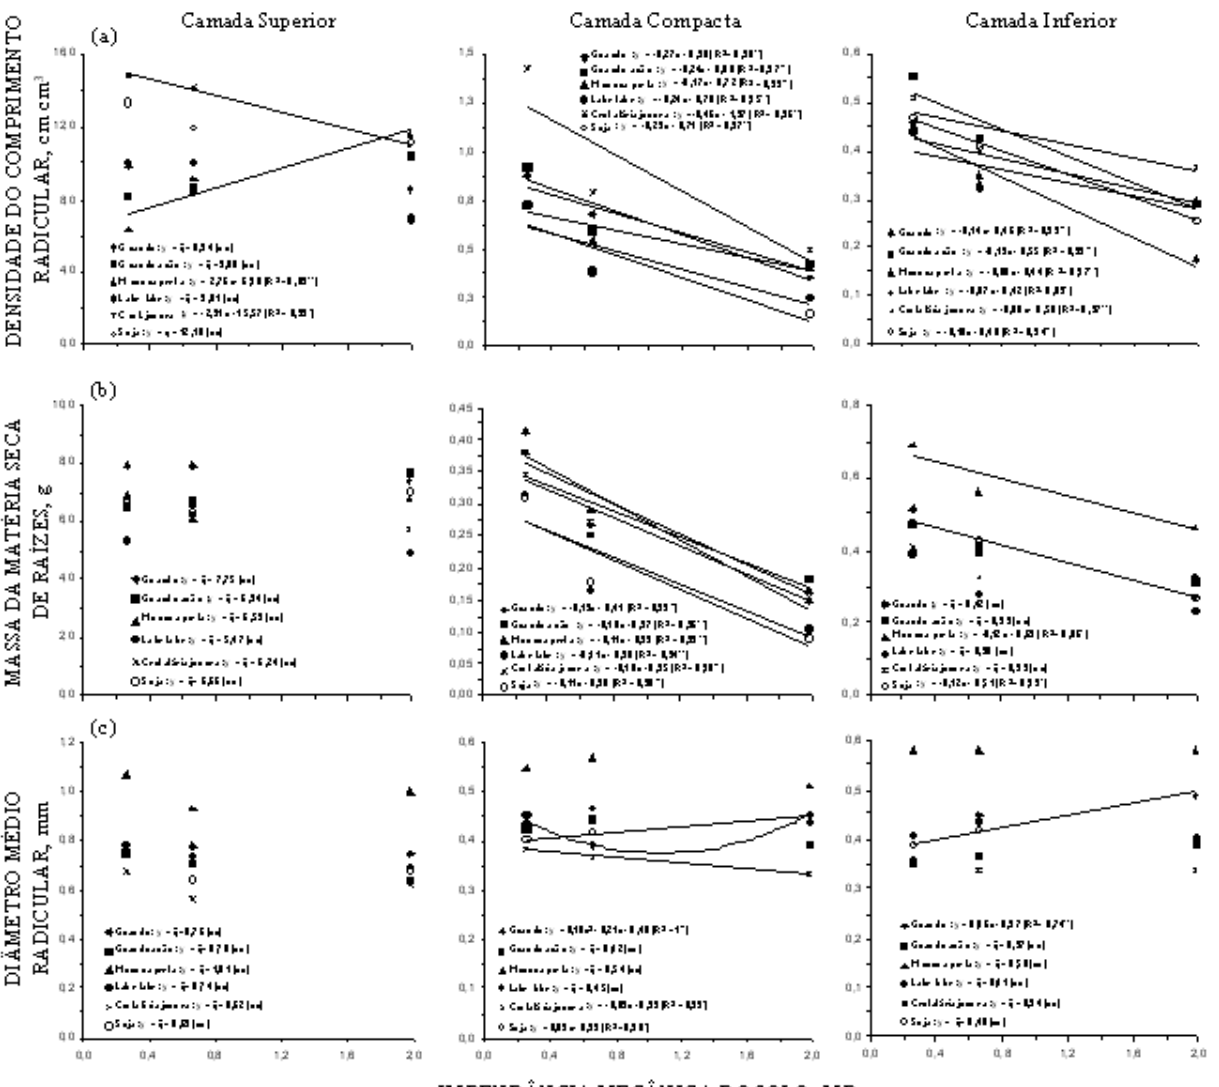
Figura 3. Densidade do comprimento radicular (a), massa da matéria seca de raízes (b) e diâmetro médio radicular (c) das plantas de cobertura e da soja, nas camadas superior, compactada e inferior dos vasos, decorrentes da impedância mecânica do solo. * e ** significativos a 5 e 1 %, respectivamente. ns: